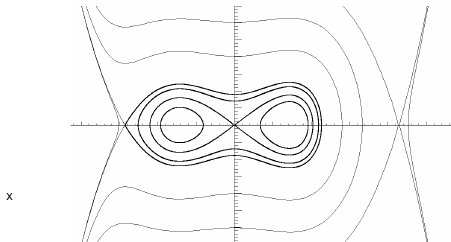
Figure 1. Functions g ( x ) and G ( x ) (the primitive).